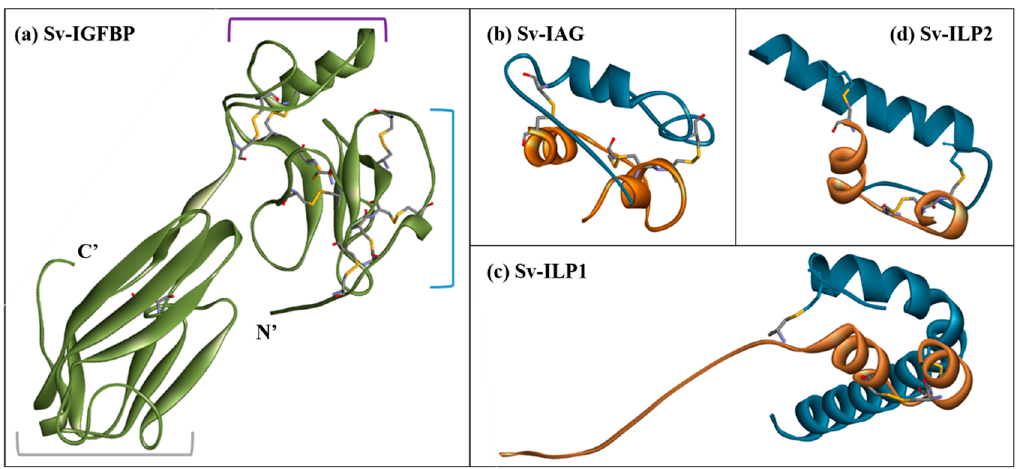
Figure 4. Molecular structure models of ( a ) Sv-IGFBP, the domains of which are indicated with: a blue bracket for the highly structured N’ insulin-binding domain; a purple bracket for the linking kazal domain; and grey bracket for the C’ immunoglobulin domain. ( b ) Sv-IAG, ( c ) Sv-ILP1, and ( d ) Sv-ILP2 are shown as previously described with the A-chain in orange and B-chain in blue. All structures are shown in secondary structure ribbon format with disulfide bonds highlighted as sticks.